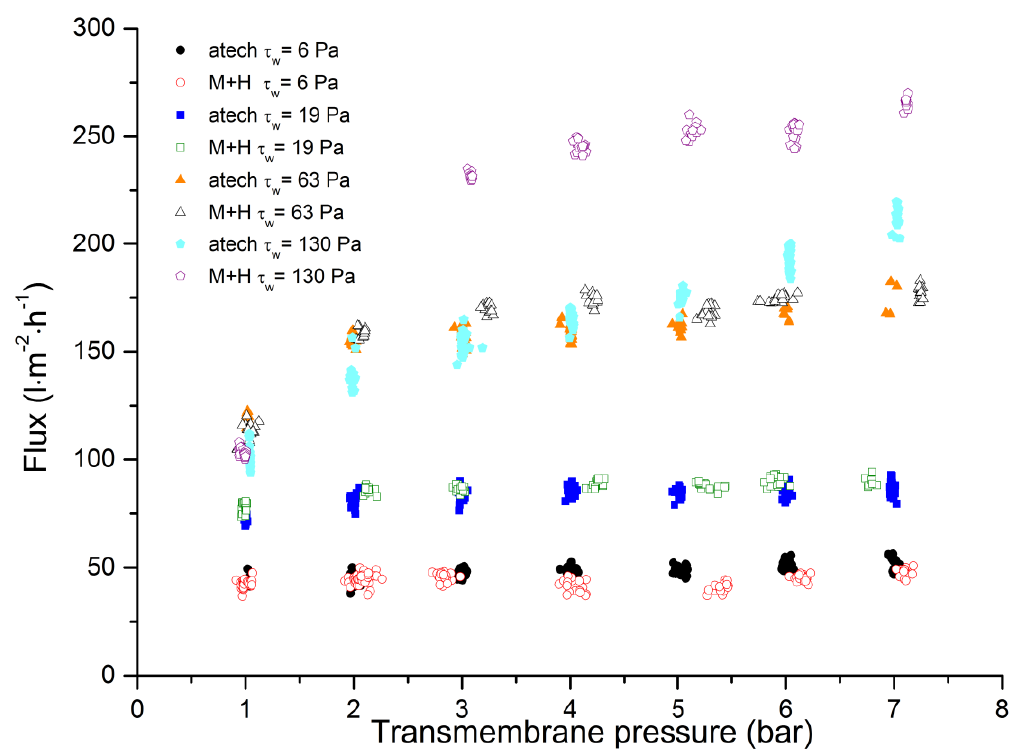
Figure 5. The relationship between transmembrane pressure and permeate flux for the 20-kDa tubular ceramic membrane and the 8-nm hollow-fiber membrane during the filtration of spent sulfite liquor.